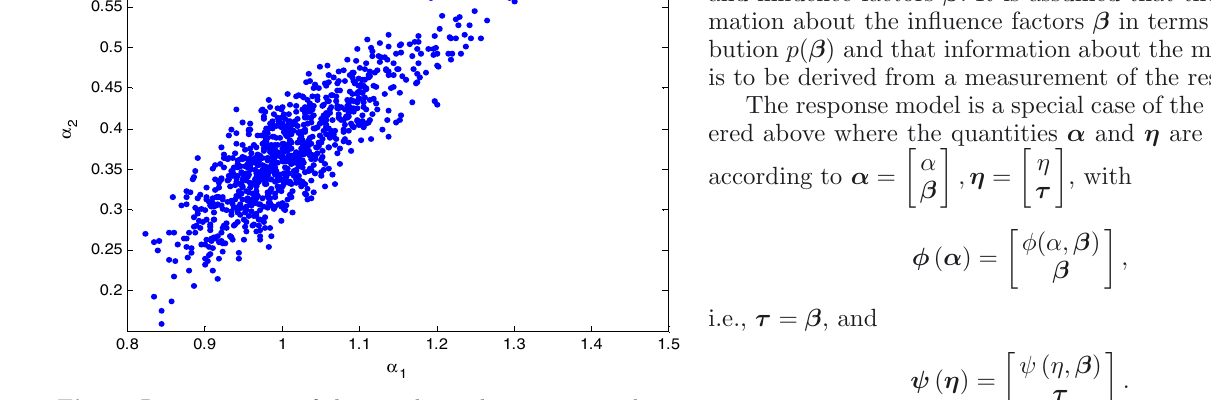
Fig. 4. Representation of the correlation between α 1 and α 2 .